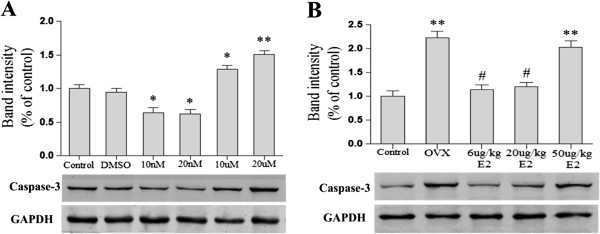
The expression of pro-caspase protein casepase-3 in PC12 cells and ischemic penumbra. (A) Pre-treatment with 10 nM or 20 nM E2 significantly attenuated OGD-R-induced the expression of pro-apoptotic protein caspase-3 (*p <0.05, v.s. DMSO group). Pre-treatment with 10 μM or 20 μM E2 increased the expression of caspase-3 (*p < 0.05, **p < 0.01, v.s. DMSO group). (B) OVX significantly increased the expression of caspase-3 in the ischemic penumbra (**p < 0.01, v.s. the control group). Treatment with 6 μg/kg or 20 μg/kg E2 significantly reduced the expression of caspase-3 (# p < 0.05, v.s. the OVX group). Treatment with 50 μg/kg E2 significantly increased the expression of caspase-3 (**p < 0.01, v.s. control group and 6 μg/kg or 20 μg/kg E2 replacement group).